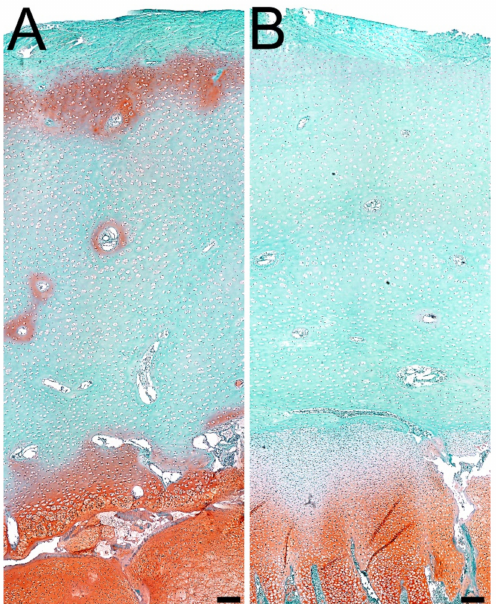
Figure 5. Representative photos of Safranine O staining carried out on formaldehyde-fixed sections from the articular cartilage of tibia of animals at 42 days of age. Control group ( A ); experimental group ( B ). Differences were observed in proteoglycan staining in tibial articular cartilage. Staining with Safranin O indicates the presence of proteoglycans, the red color in the matrix. All the scale bars represent 8 µ m.